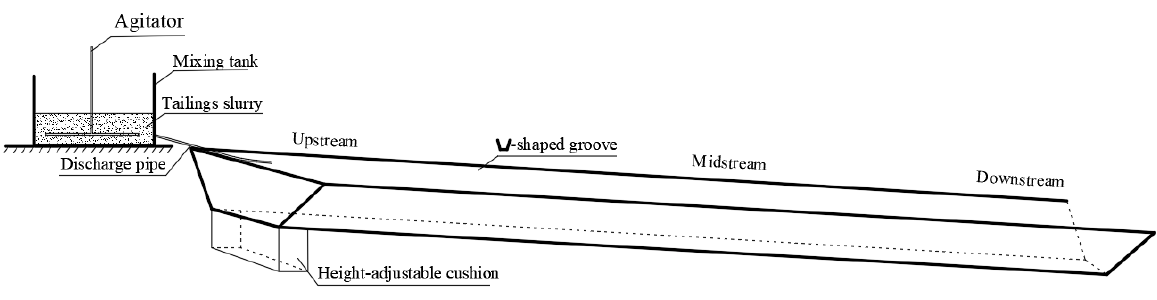
Figure 3. Schematic diagram of the physical model for the tailings hydraulic sedimentary test. According to the Froude criterion [22], when fluid flow is dominated by inertial force and gravitational force, the physical model and prototype of fluid should have the same Froude number to meet the dynamic similarity conditions. The Froude number is the ratio of inertial force to gravitational force during the process of fluid flow, as shown in